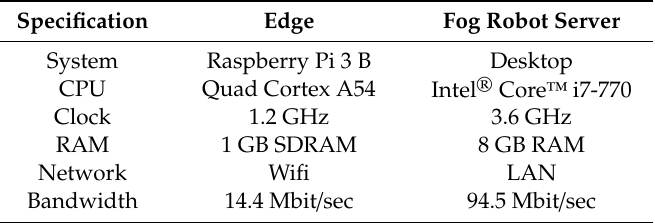
Table 4. The system specification of an edge and a fog robot server.